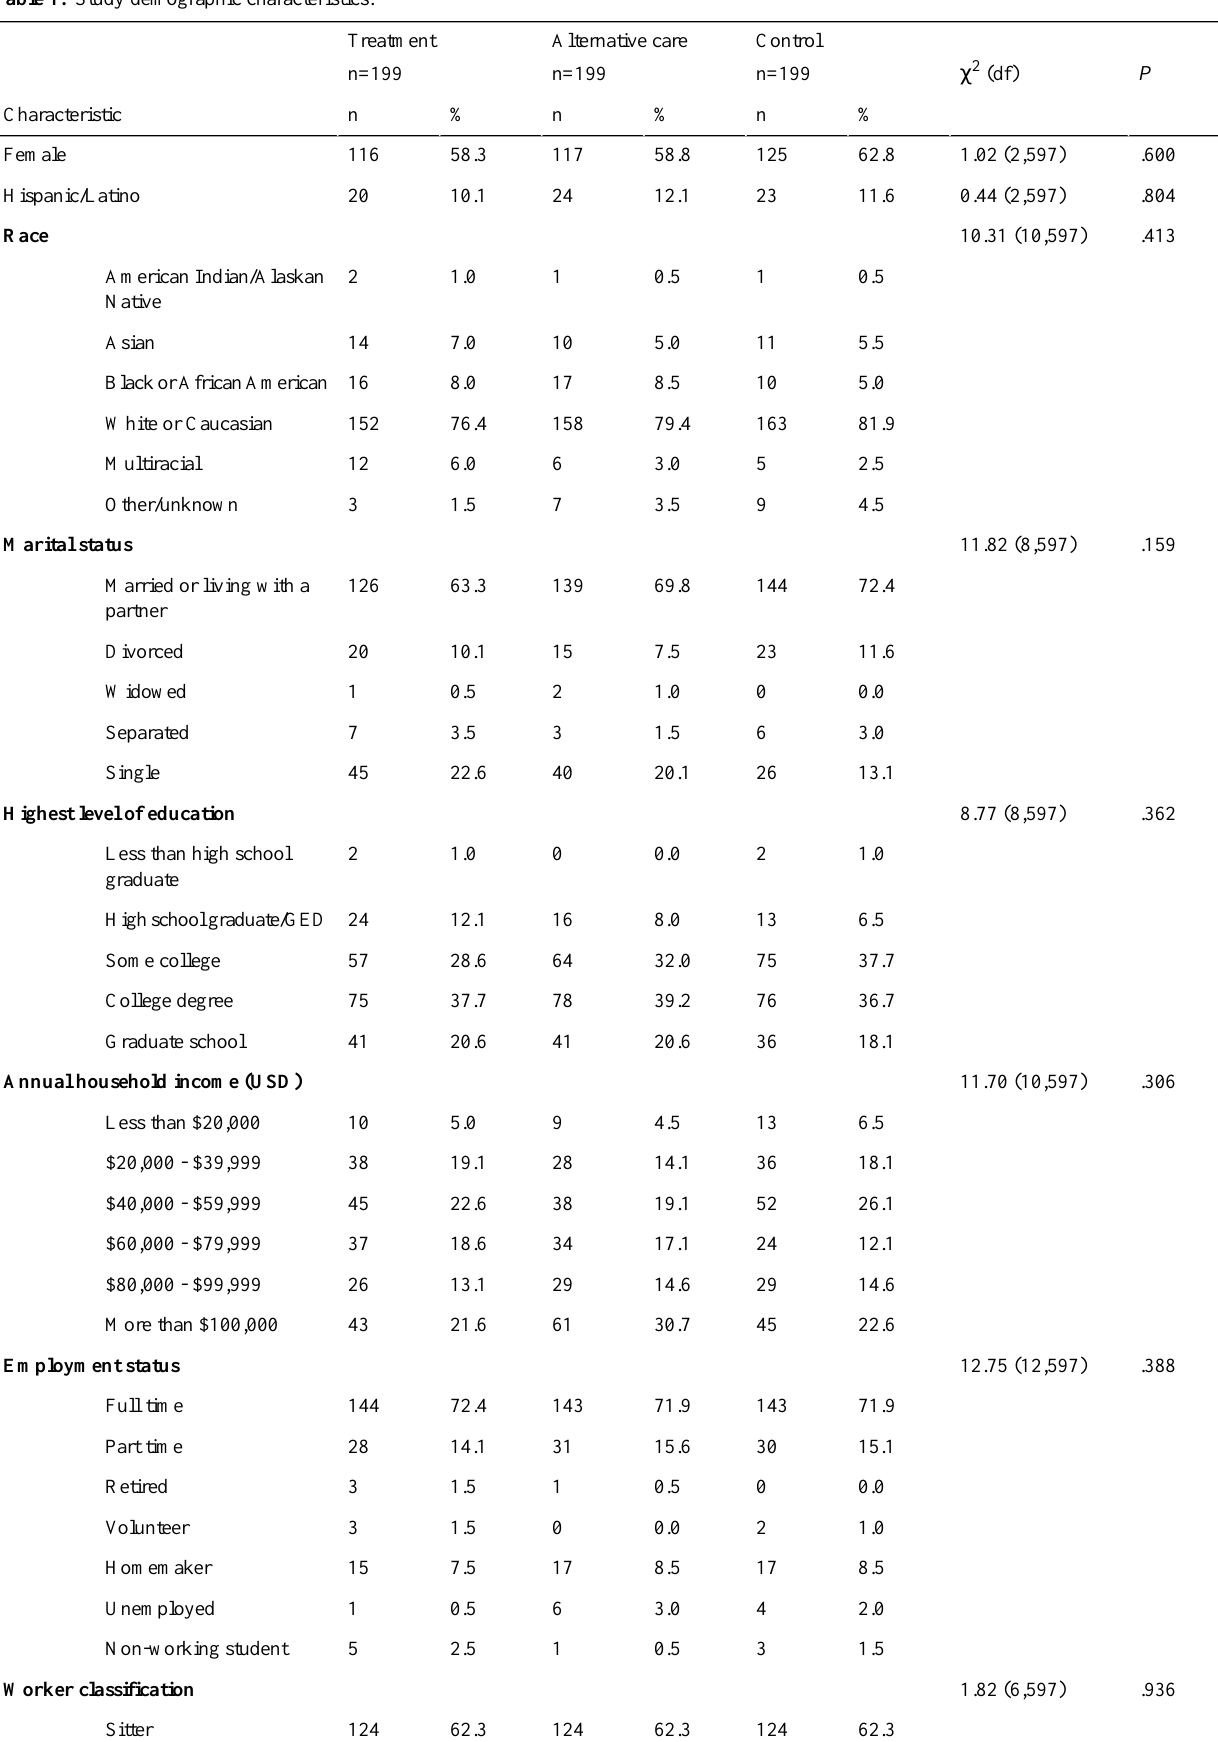
Table 1. Study demographic